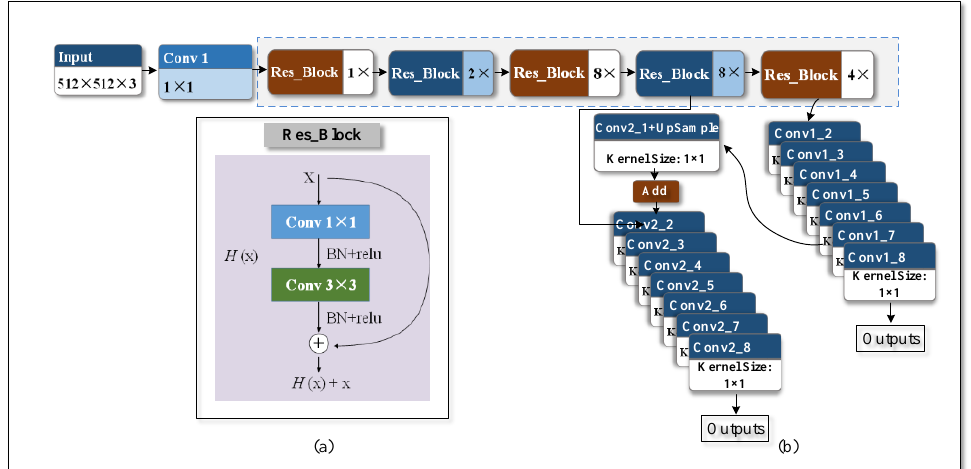
Figure 5. Simplified-Net Flow chart. ( a ) is the Res_Block module and ( b ) is Simplified-Net network structure. Table 2. Comparison between original and simplified network.